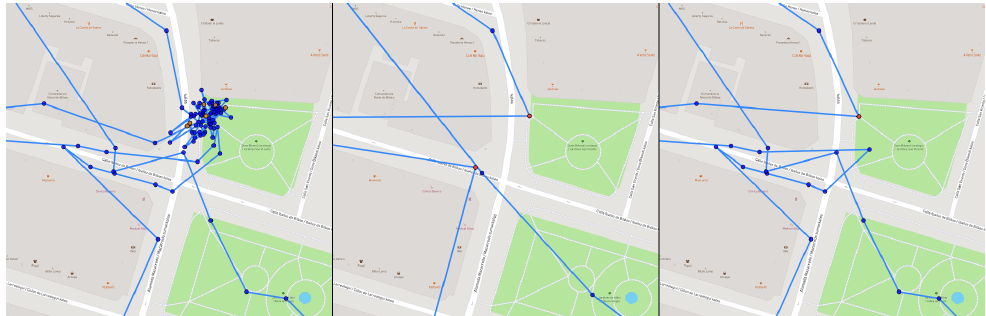
Figure 8. Normal clustering, raw ( left ), first iteration ( center ), second iteration ( right ).